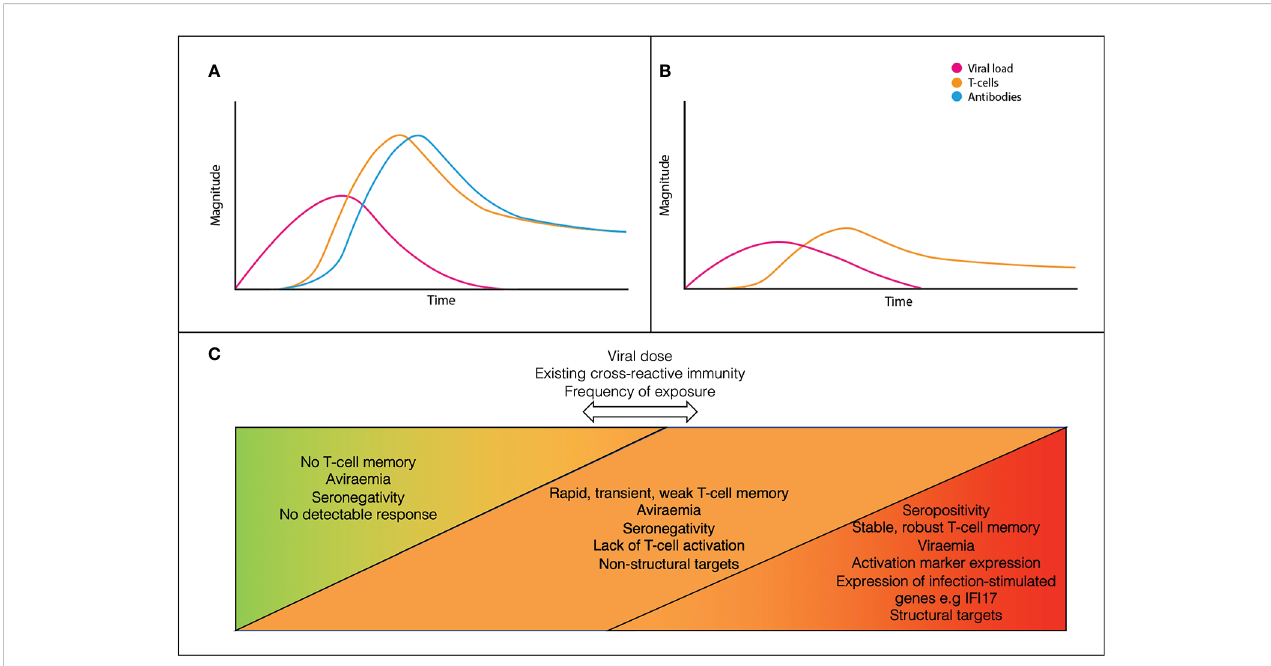
FIGURE 1 A conceptual model for the dynamics of canonical acute infection (A) vs ESN infection (B) . ESNs (orange) represent points along a spectrum of immune engagement, in fl uenced by viral dose, immune cross-reactivity, and frequency of exposure (C)